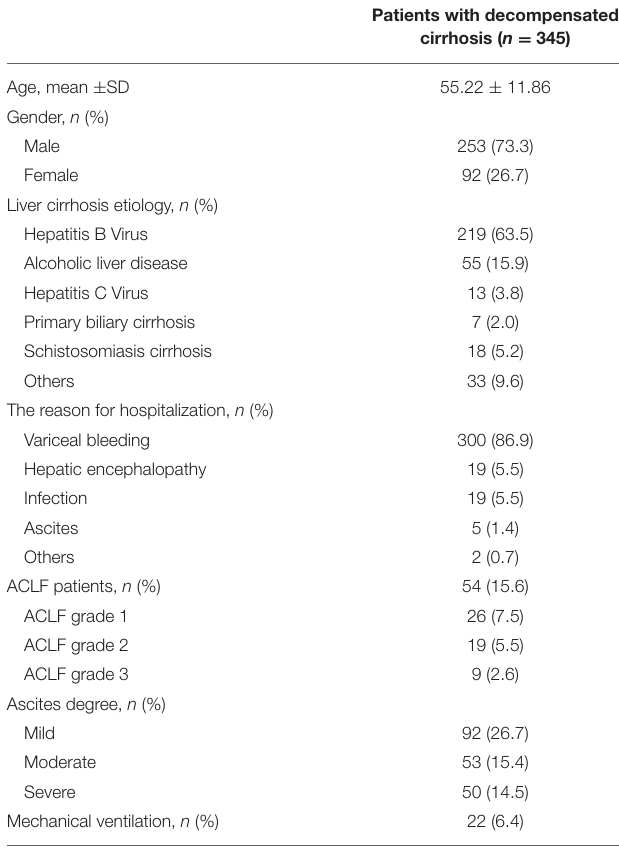
TABLE 1 | Characteristics of the included